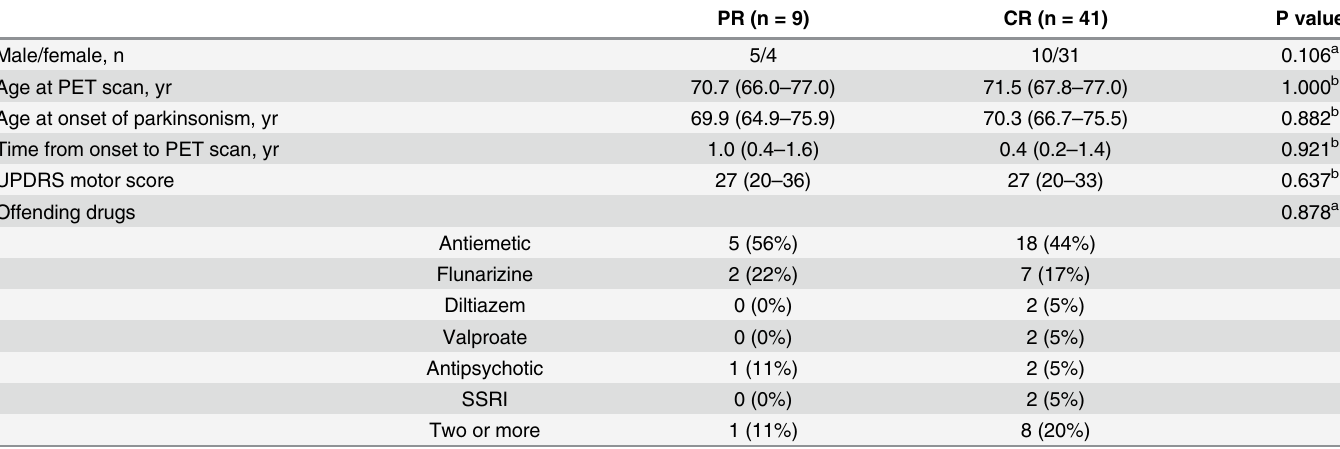
Table 2. Demographic characteristics of the